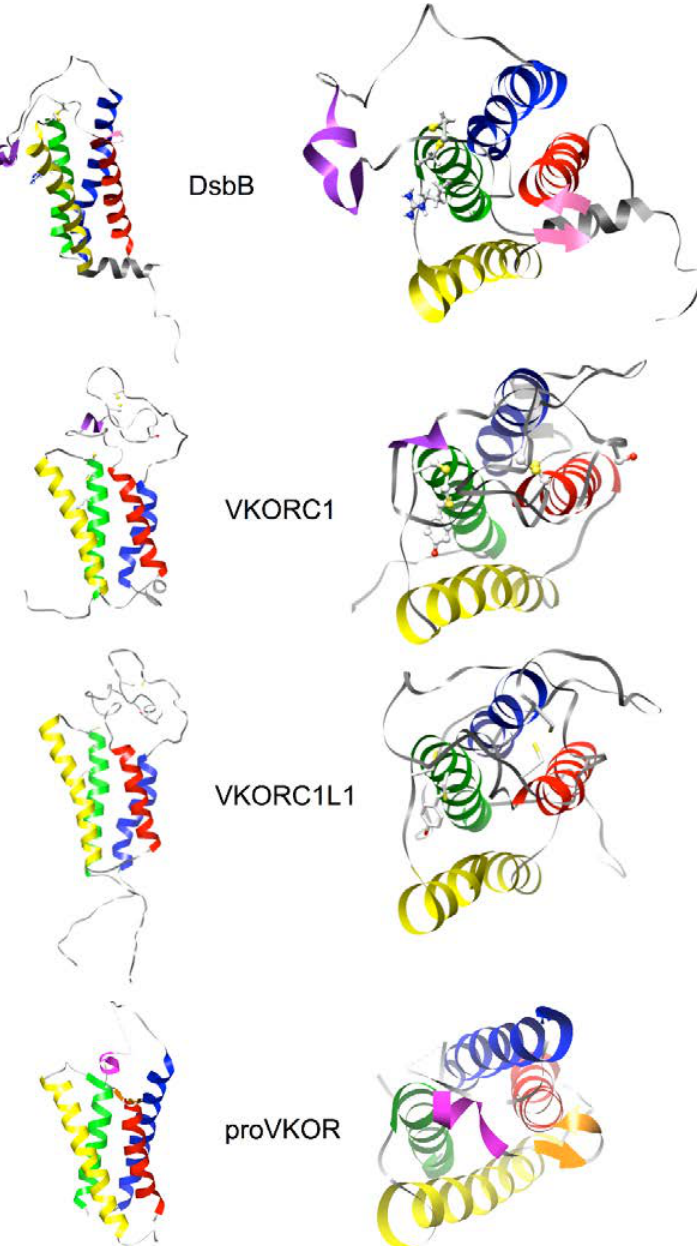
Figure 6. Backbone ribbon renderings of DsbB (PDB entry 2K74, model 1) [45], homology models of human VKORC1 and VKORC1L1 (Note 1 [67]), and Synechococcus sp. VKOR (proVKOR; PDB entry 3KP9) [14]. Views in the plane of the lipid bilayer (left) and normal (right) to the membrane plane from the ER lumenal (for VKORC1, VKORC1L1, proVKOR) or periplasmic (for DsbB) side. Transmembrane helices are colored (from N- to C-terminus) blue, red, yellow, green (designated as A, B, C and D, respectively, throughout the article text). Short loop helices for DsbB and VKORC1 (purple), for proVKOR (magenta); short β -sheet are regions (magenta or orange arrows); loop cysteines (ball and stick side-chains with yellow sulfur atoms).